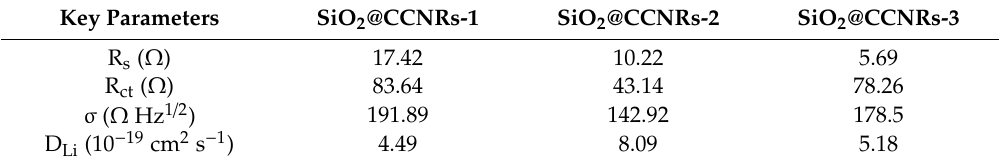
Figure 3. ( a ) Nyquist plots and ( b ) lithium ion diffusion coefficients of different anodes inLIBs . Table 1. Kinetic parameters of SiO 2 @CCNRs-1, SiO 2 @CCNRs-2, and SiO 2 @CCNRs-3 anodes.